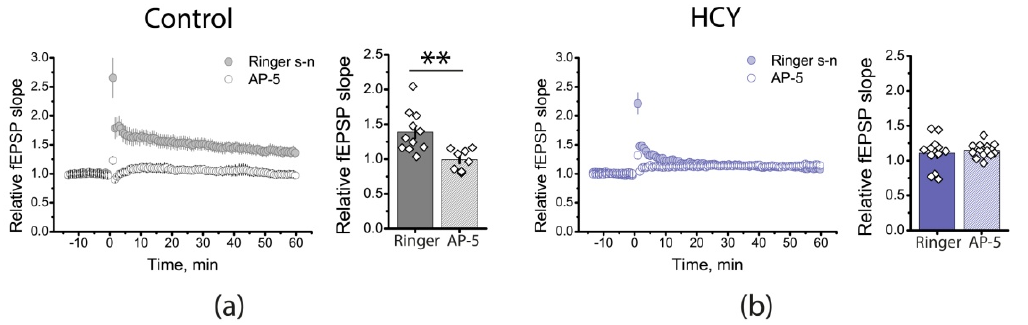
Figure 4. Effects of NMDARs blockade on LTP induction in the hippocampus of control and HCY rats. The normalized fEPSP slope in the presence of the NMDAR blocker AP-5 (50 μ M), before and after TBS in the control ( a ) and experimental groups ( b ). ** p < 0.01: a significant difference ( t -test).